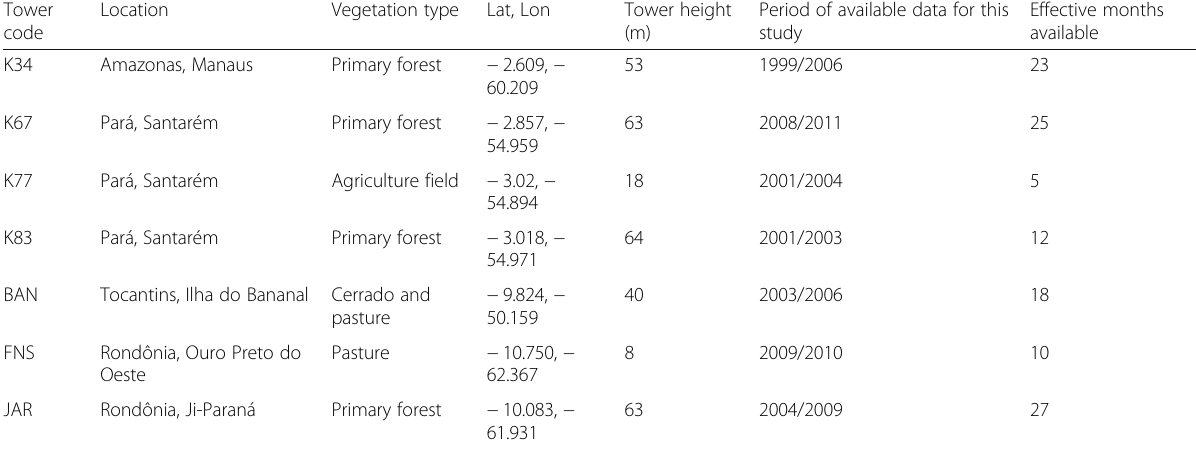
Table 1 Flux tower sites in the Amazon River Basin and period of available data for the present study Tower